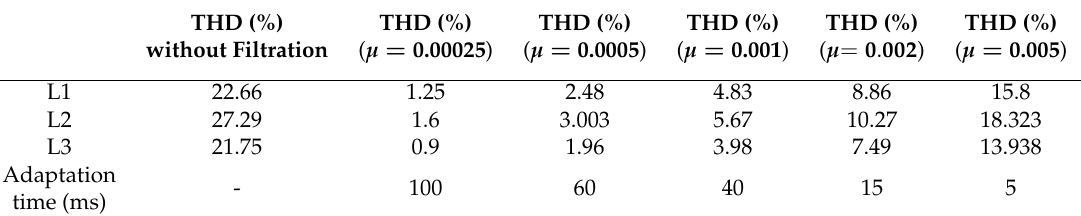
Figure 32. An example of the filtration for all phases for the value µ = 0.001, the resulting THDs for the depicted currents correspond to the highlighted column in Table 4. The waveforms of the currents show that the adaptation time is between 40 ms and 50 ms. Table 4. THD values in the switched on state before and after application of the adaptive LMS